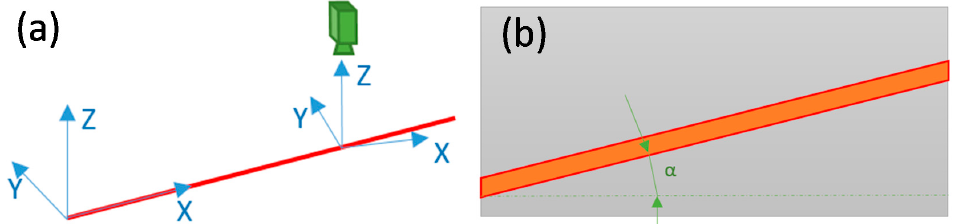
Figure 3. Scheme of the system for the measurement of the cart yaw ( a ) and extraction of the yaw angle from the image ( b